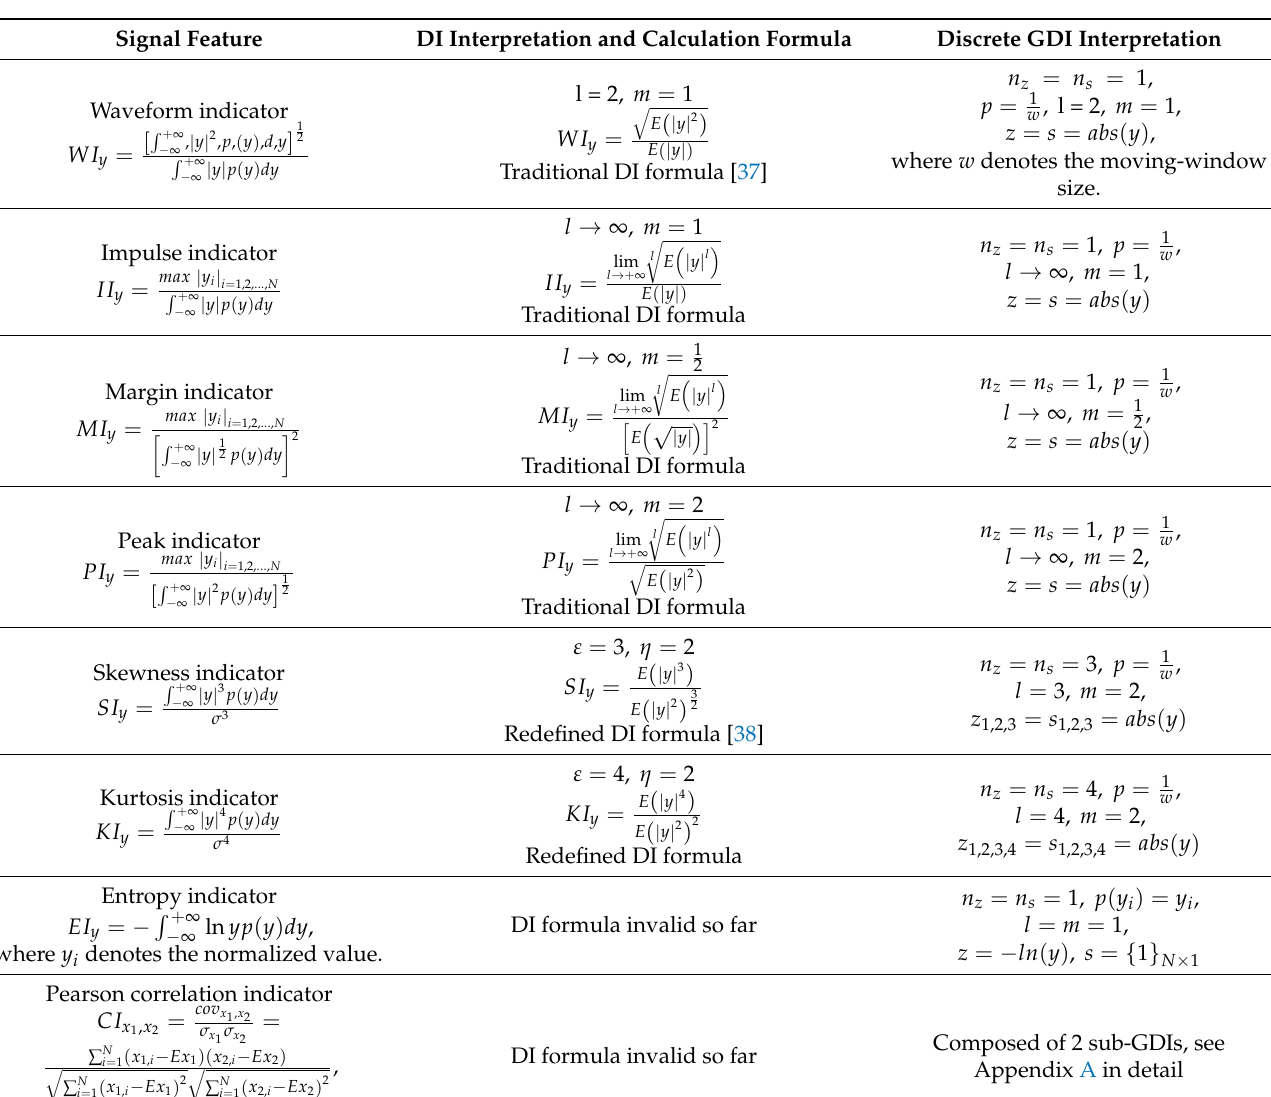
Table 1. Dimensionless Signal Features [30] and Corresponding